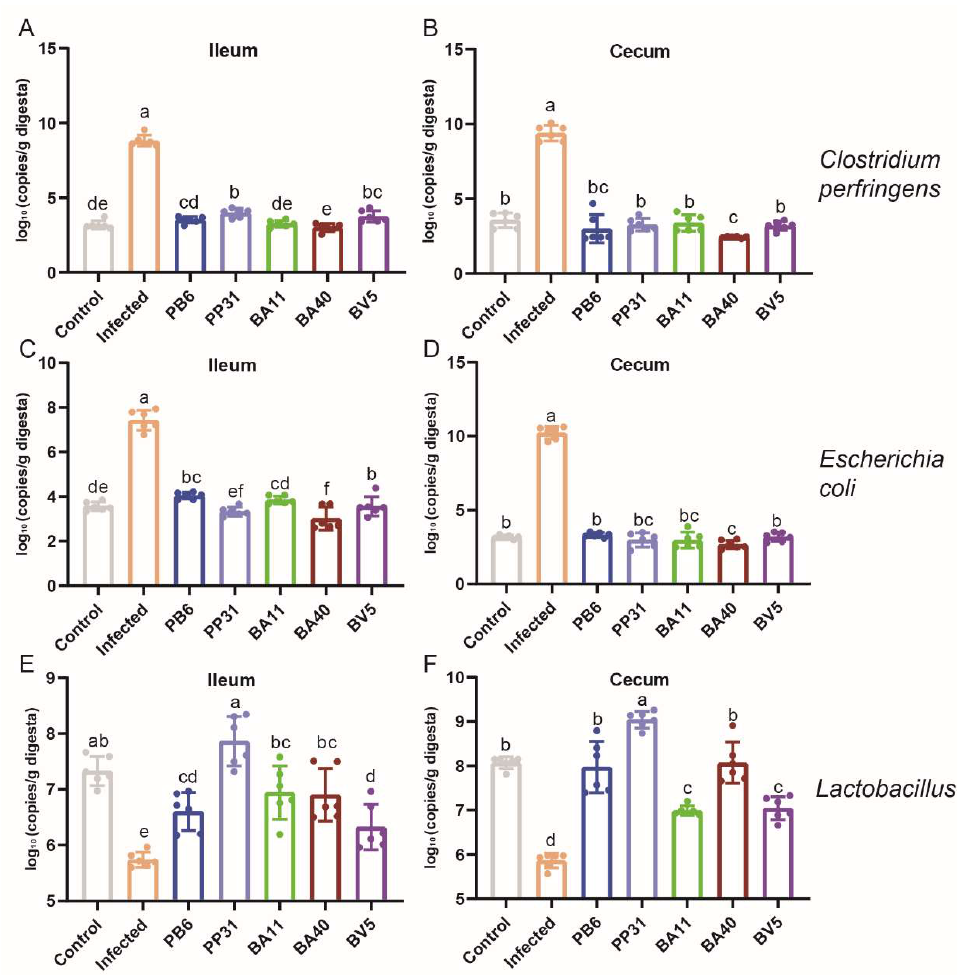
Figure 7. The population of intestinal microbiota of mice. ( A ) Clostridium perfringens in the ileum. ( B ) Clostridium perfringens in the cecum. ( C ) Escherichia coli in the ileum. ( D ) Escherichia coli in the cecum. ( E ) Lactobacillus in the ileum. ( F ) Lactobacillus in the cecum. Results are presented as mean ± SD (The data were presented as log10 gene copies/g of intestinal digesta). a, b, c, d Means values with dissimilar letters were significantly different ( p < 0.05).